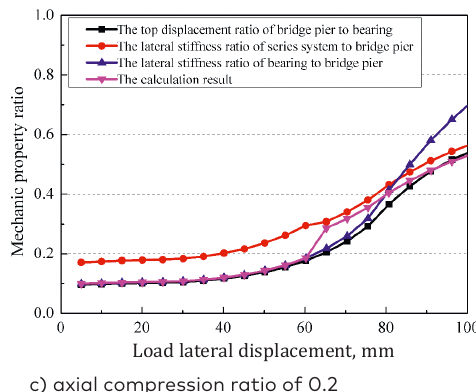
a) axial compression ratio of